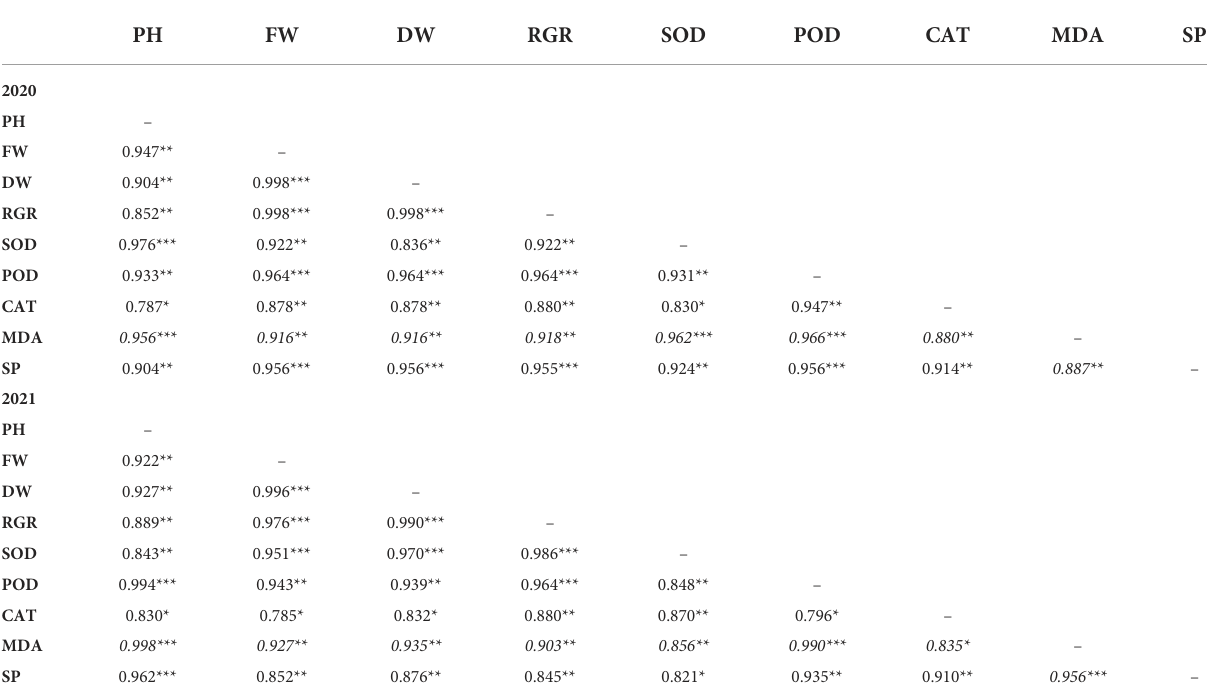
TABLE 5 The correlations ( R 2 ) of antioxidant enzymes with growth and of sesbania pea across growth stages under different nitrogen and phosphorus combinations. PH FW DW RGR SOD